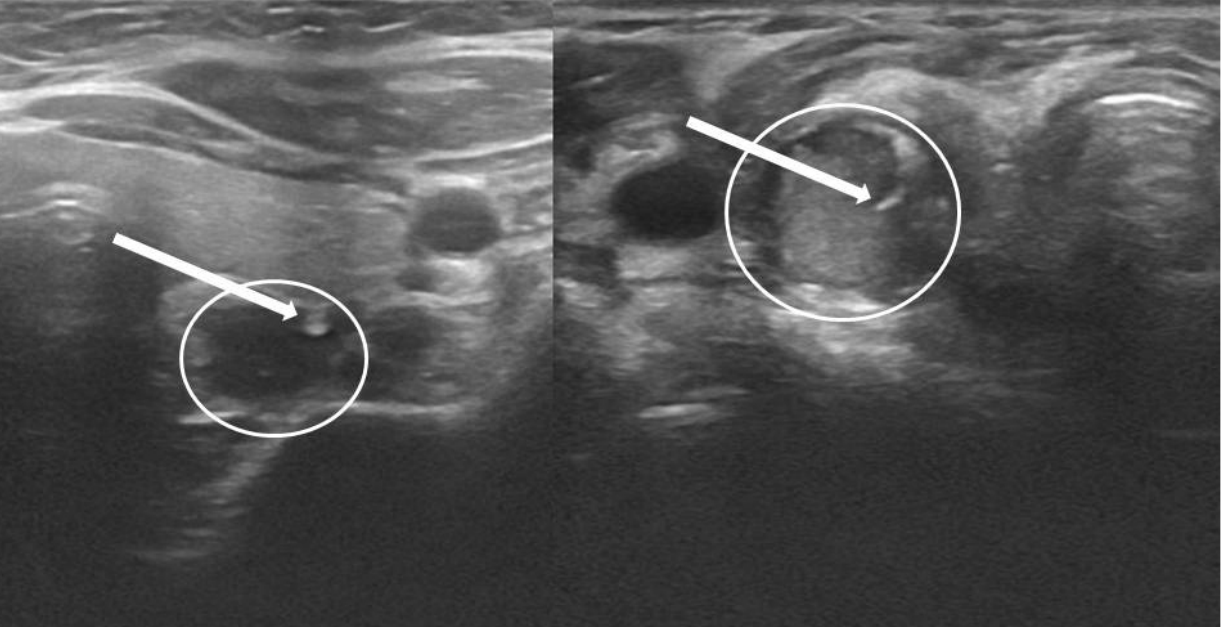
Figure 1. QuOBo score examples. Left image—QuOBo2; the tip of the needle (end of arrow) inside the parathyroid (in a circle) close to the border. Right image—QuOBo3; the tip of the needle (end of arrow) in the middle of the parathyroid (in a circle).